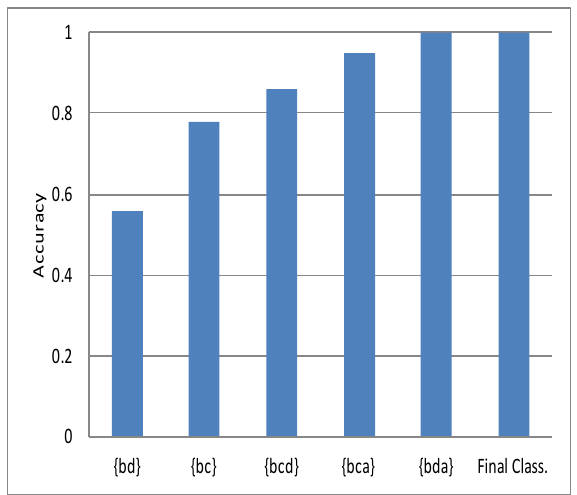
Fig. 8. Classification accuracy by reducts and weighted modified reducts by mapping